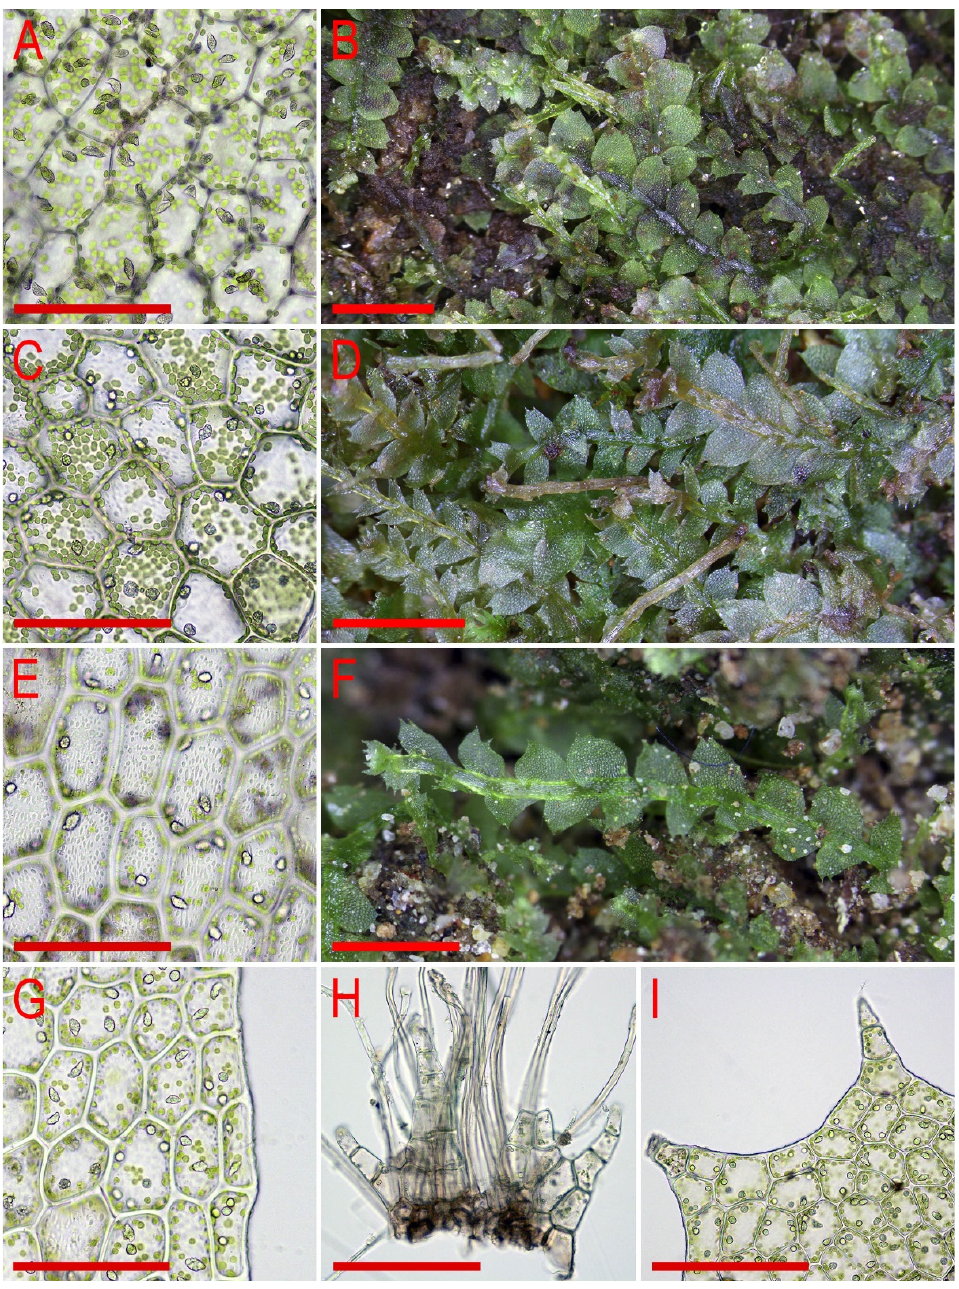
Figure 13. Asperifolia indosinica Bakalin et Troizk., sp. nov. : ( A , C , E ) Midleaf cells with oil bodies; ( B , D ) Parts of mats; ( F ) Shoot; ( G ) Leaf margin cells with oil bodies; ( H ) Underleaf; ( I ) Leaf apex cells with oil bodies. Scales: 100 µ m for ( A , C , E , G , I ); 500 µ m for ( H ); 1 mm for ( B , D , F ). ( A , B ) from